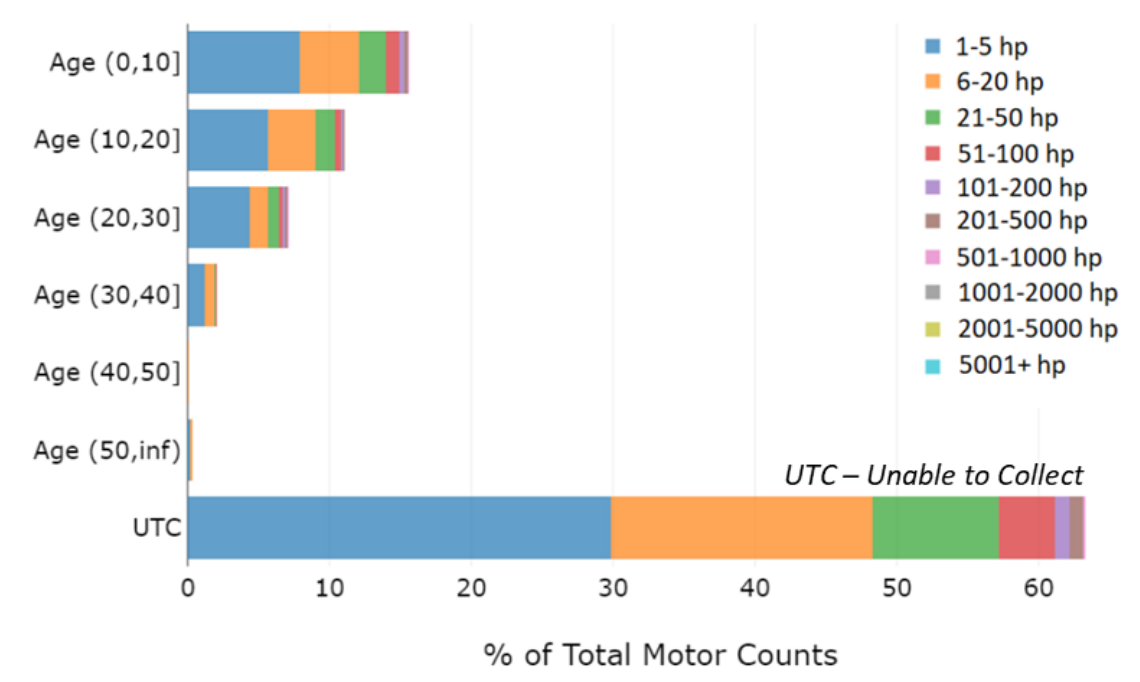
Figure 5. Age of industrial motor systems broken down by size (Source: DoE, 2021).